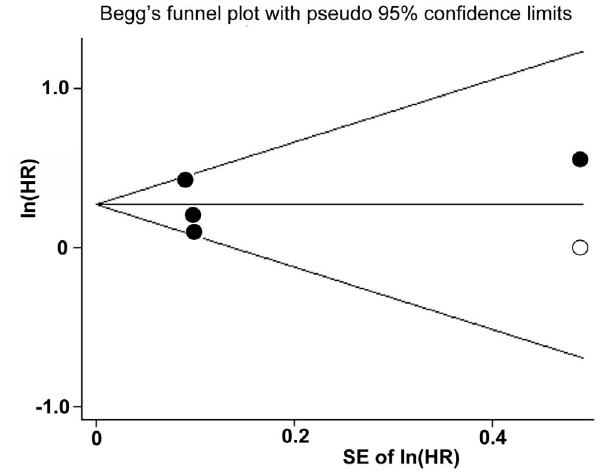
Figure 5. Funnel plots with trim and fill. The black dots present the identified studies included in the meta-analysis; the empty dot presents the estimated missing study after adjustment for publication bias.